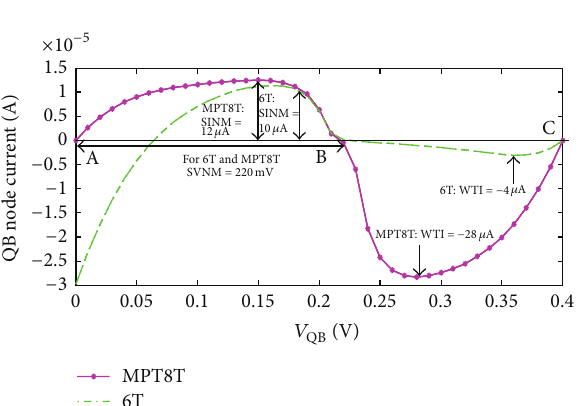
Figure 21: Read access time versus 𝑉 DD .